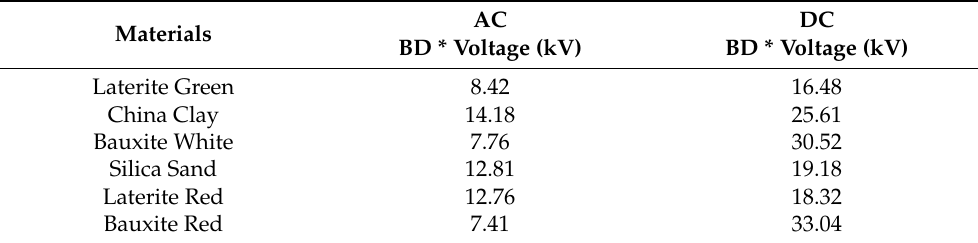
Table 4. AC and DC breakdown